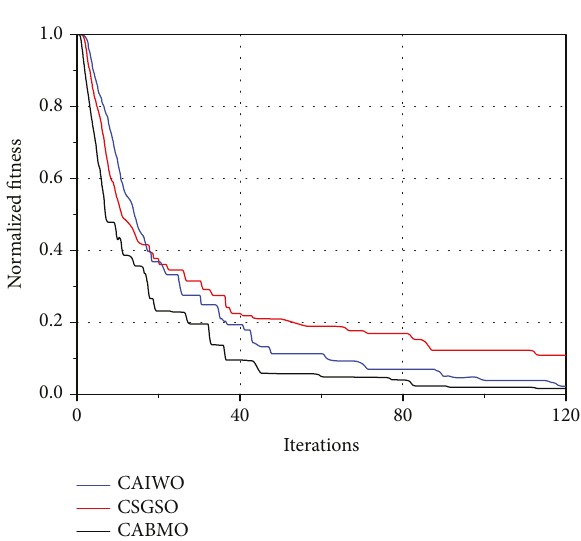
Figure 10: Convergence curves of three algorithms of the model in